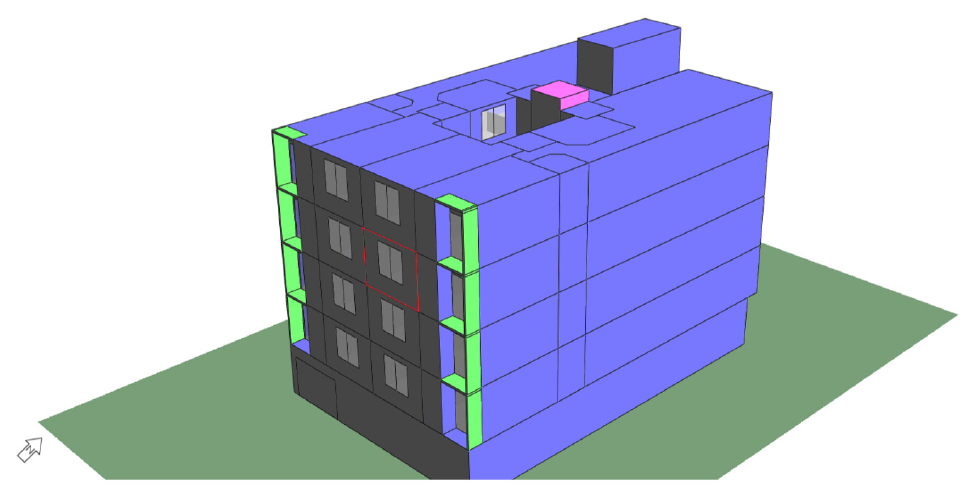
Figure 4. Integrated Environmental Solutions Virtual Environment (IES-ve) Pro 3-D model of a typical Tehran apartment